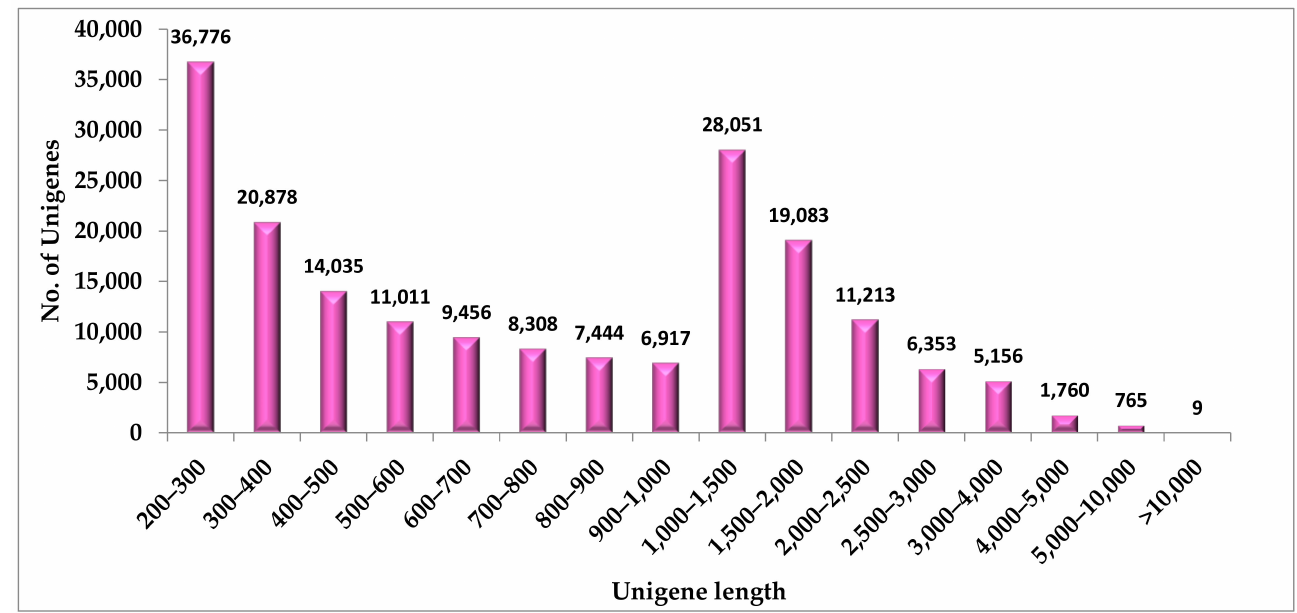
Figure 1. Unigene length distribution of S.cordifolia root